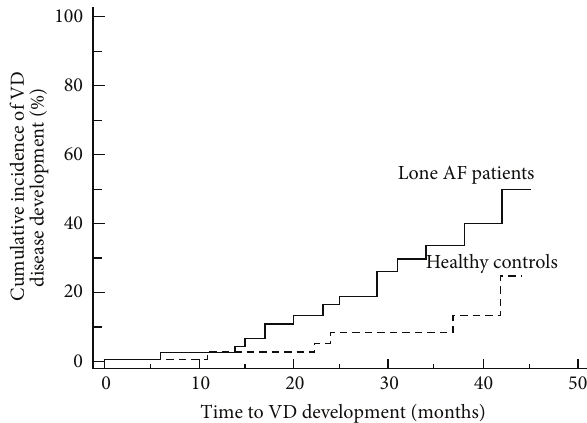
Figure 1: The Kaplan-Meier curve of cumulative risk for vascular disease development in lone AF patients and healthy controls (logrank 𝑃 = 0.014 ). VD: vascular